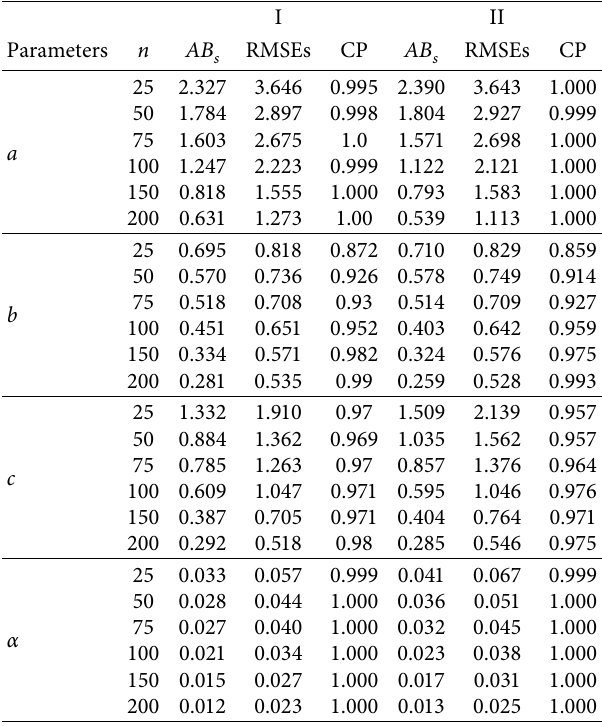
Table 3: The results of AB s , RMSEs, and CP for the MLEs of ExEW distribution for I and II.